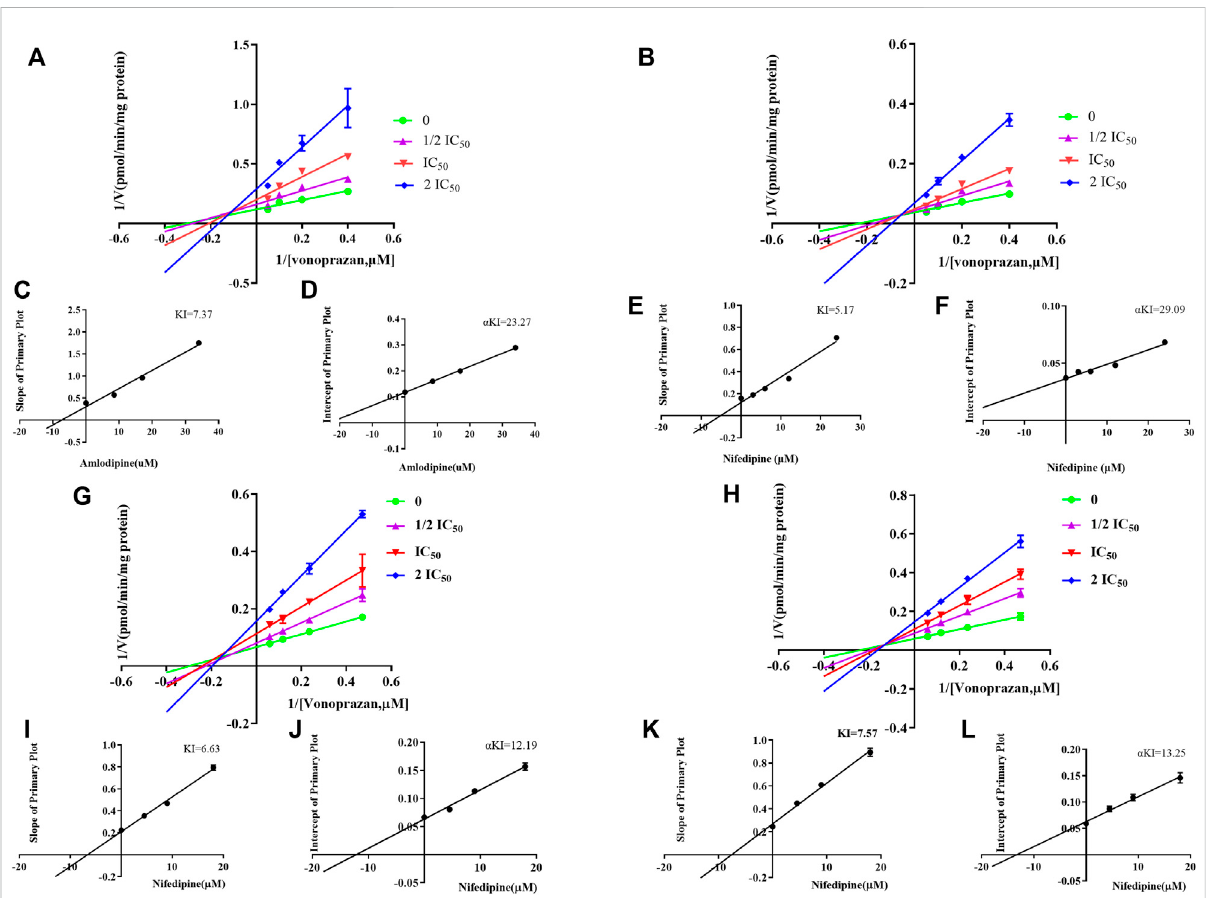
FIGURE 5 TheLineweaver – BurkandDixonplots ofamlodipineand nifedipineinhibition onvonoprazan inRLMs: (A) Lineweaver – Burkplotofamlodipine. (B) Lineweaver – Burk plot of nifedipine (C) Slope of the primary plot of amlodipine (D) Intercept of the primary plot of amlodipine. (E) Slope of the primaryplotofnifedipine. (F) Interceptoftheprimaryplotofnifedipine.TheLineweaver – BurkandDixonplotsofamlodipineandnifedipineinhibition on vonoprazan in HLMs: (G) Lineweaver – Burk plot of amlodipine. (H) Lineweaver – Burk plot of nifedipine. (I) Slope of the primary plot of amlodipine. (J) Intercept of the primary plot of amlodipine. (K) Slope of the primary plot of nifedipine. (L) Intercept of the primary plot of